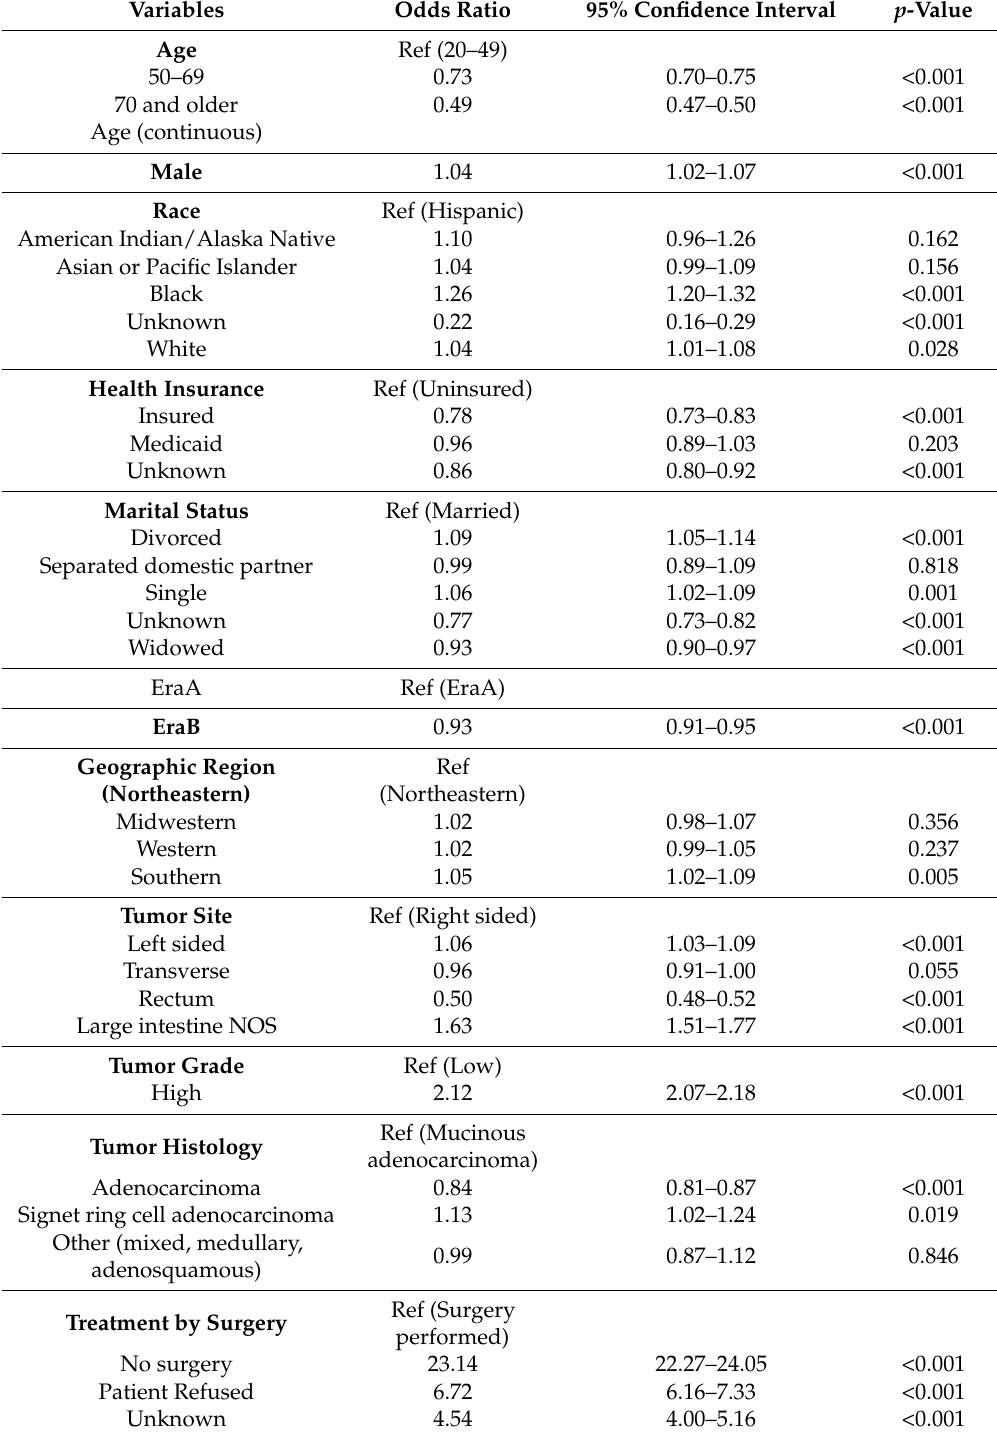
Table 2. Independent predictors for metastatic disease at